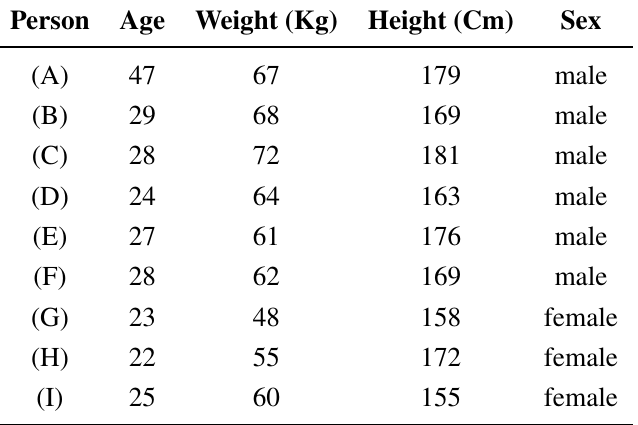
Table 1. Information about people in the first walking